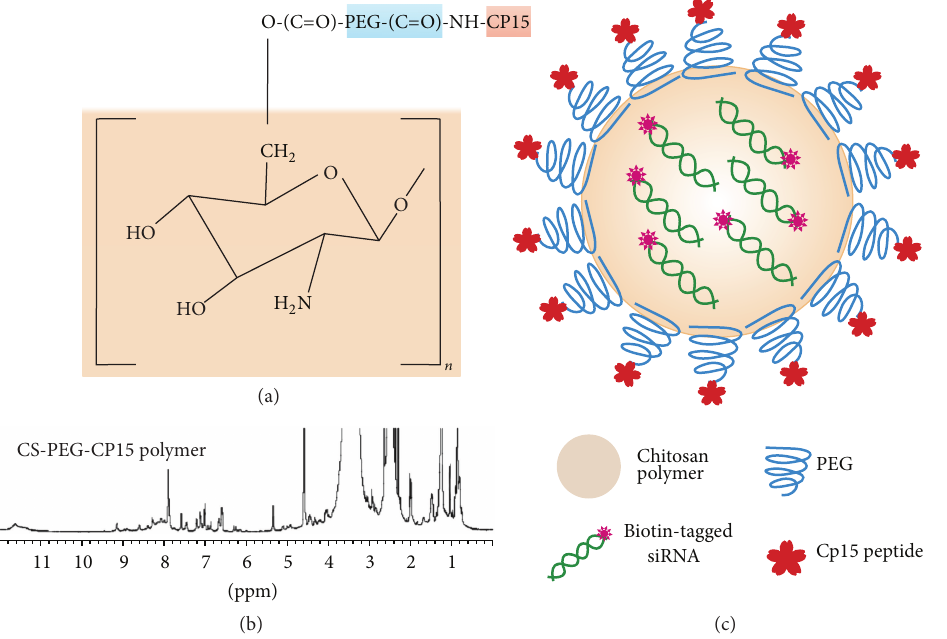
Figure 1: (a) Chemical structure of chitosan-PEG-CP15 polymer; (b) 1 H NMR spectra of chitosan-PEG-CP15 (CS-O-PEG-CONH-CP15). The multiple peaks of oxymethyl groups in PEG at 𝛿 3.3 to 3.7 cover over the signals of pyranose ring of chitosan. The multiple peaks at 𝛿 6.0–9.0 belong to the peptide CP15 sequence, respectively. (c) A nanoparticle formulation with a core formed by chitosan polymer, surface functionalized with PEG, and a cell-targeting peptide (CP15). The formulation encases a biotin-tagged